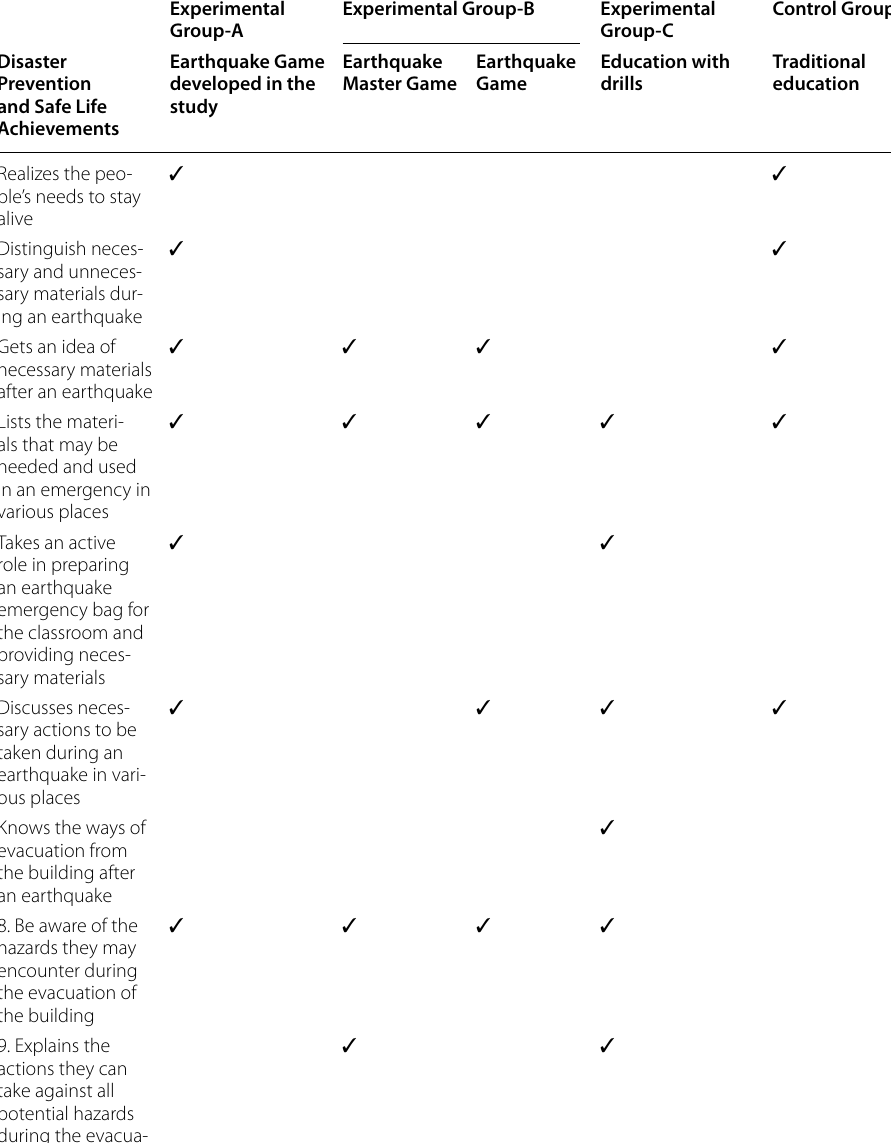
Table 2 Content-based comparison of different educational practices according to the